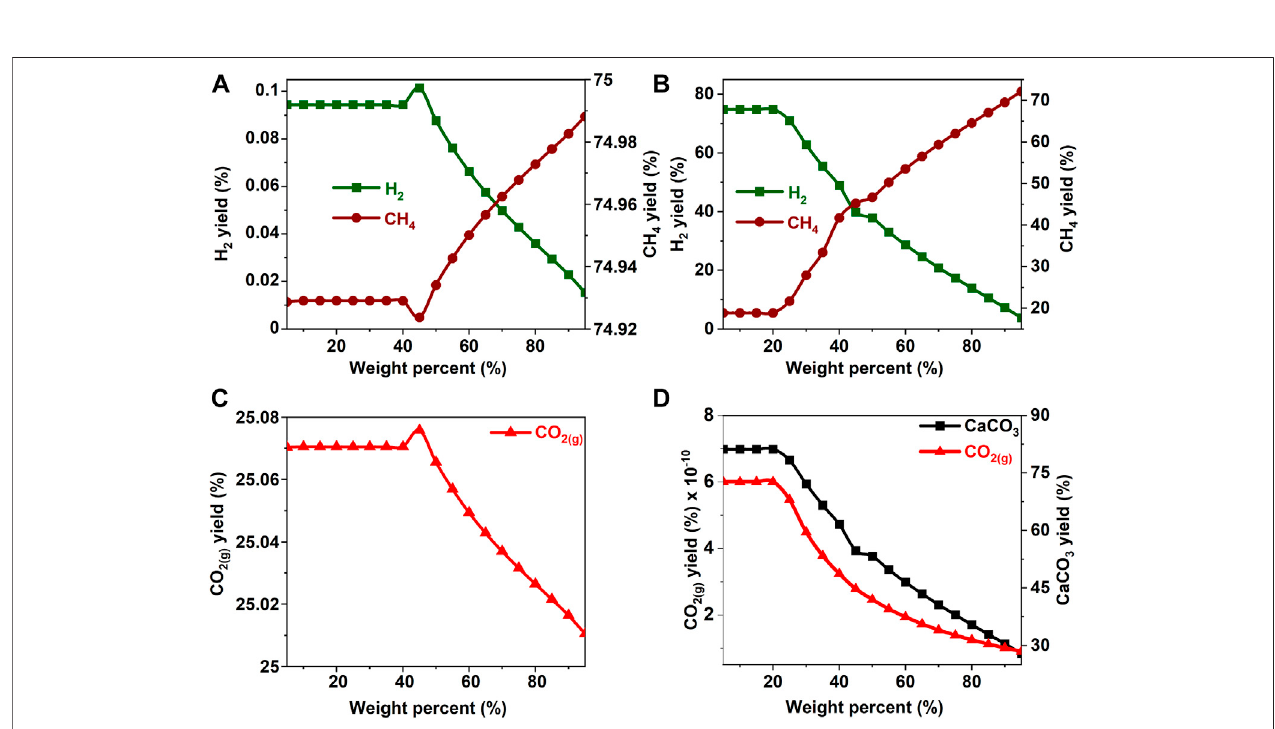
FIGURE 4 | Effect of ethanol concentration on the product yield (A , C) in the absence and (B) in the presence of calcium oxide. The yield of CO 2 post capture to produce calcium carbonate is represented in 2 (D) . These calculations are performed with temperatures of 227 ° C and pressures of 50 bar.